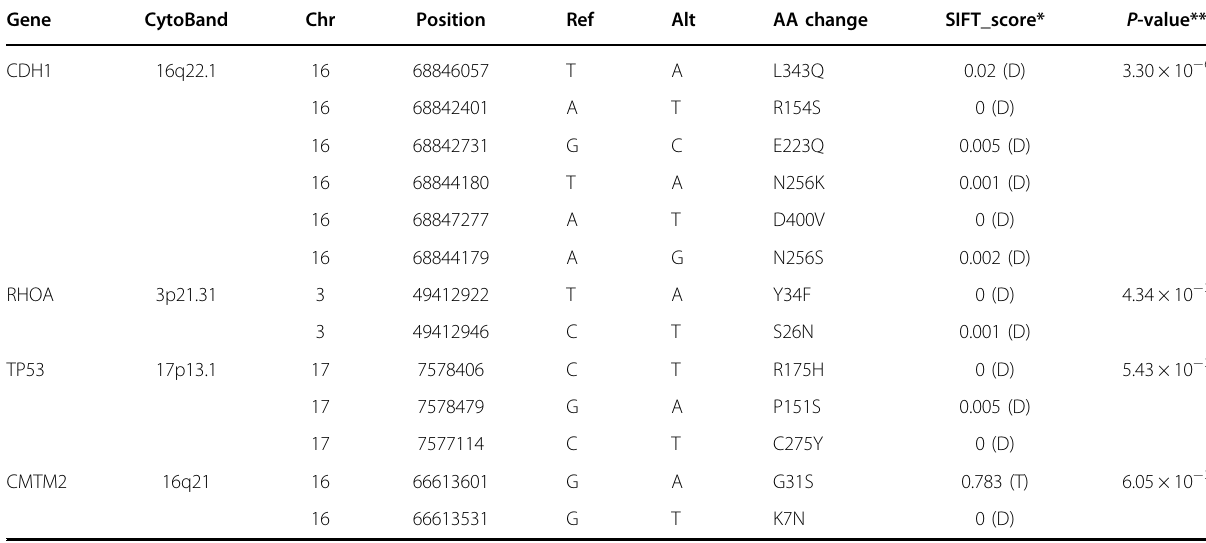
Table 2 List of the signi fi cantly mutated genes in